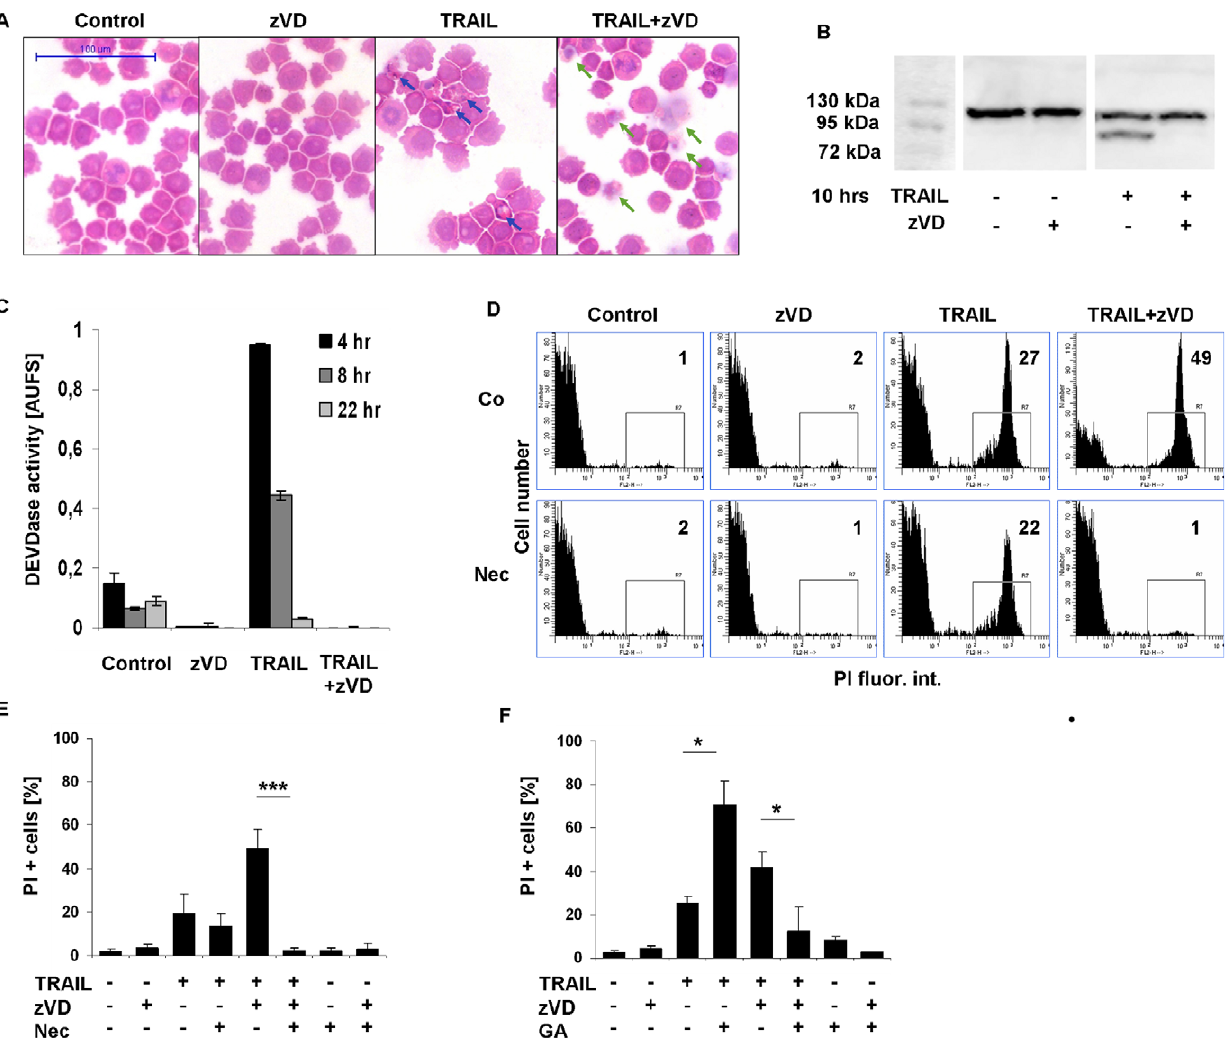
Figure 1. TRAIL induces necroptosis in the presence of caspase inhibitor. TRAIL-induced cell death in U937 cells. Cells were treated as indicated for 20 hrs. (A) Cytospins were stained with hematoxylin-eosin. Blue arrows show the apoptotic, green ones the necrotic cells (400x) (representative of n=2). Scale bar on the first subfigure applies to all the figures in the panel. (B) Western blot analysis of fragmented PARP-1 protein. Full length PARP-1 is 116 kDa, cleaved PARP-1 fragment is 89 kDa (representative of n=2). (C) TRAIL-induced caspase activity in U937 cells. U937 cells were exposed to 50 ng/mL hr-TRAIL (114–281 aa) in the presence or absence of zVD (5 m M) for the indicated period of time. The ordinate shows the slope of the measured DEVDase activity curves of a representative experiment carried out in triplicates. (D) FACS analysis of treated cells. Plasma membrane integrity was analyzed after PI staining of cells. Inserted values on histograms show the percentage of the marked population (representative of n=7). (E-F) Nec and GA protected U937 cells from TRAIL + zVD-induced necroptosis. U937 cell were exposed to TRAIL (50 ng/mL) in the presence or absence of zVD (5 m M) and (E) Nec (10 m M) or (F) GA (1 m M) for 20 hrs. PI stained cells were analyzed for membrane permeability. Percentages of PI positive cells were determined (n=7 for Nec and n=4 for GA). Values are mean 6 SD. *, P , 0.05, **, P , 0.01 and ***, P , 0.001 calculated by Student’s t-probe.